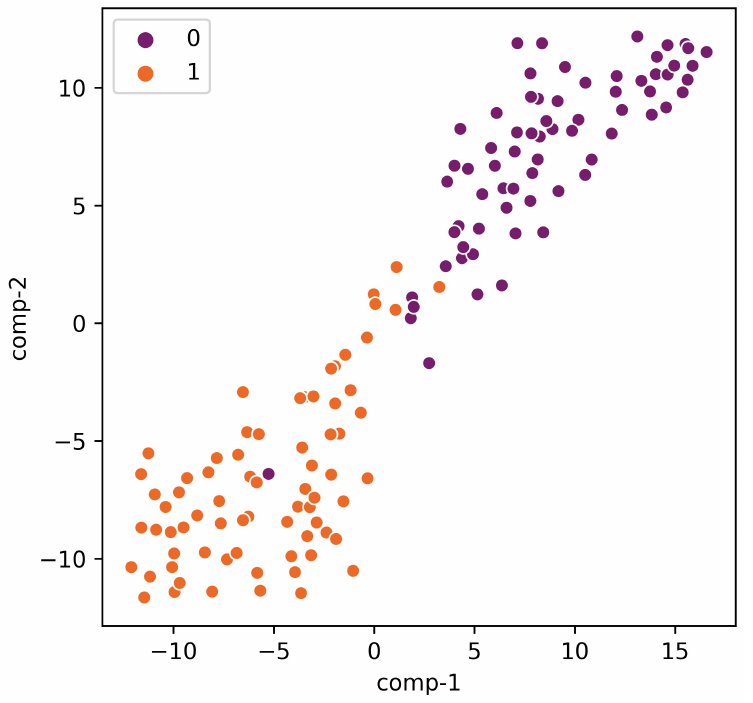
Figure 4. The t-SNE visualization of the learned features of the G. subterraneus dataset using the proposed model. The “0” represents the features of the negative samples and “1” represents the features of the positive